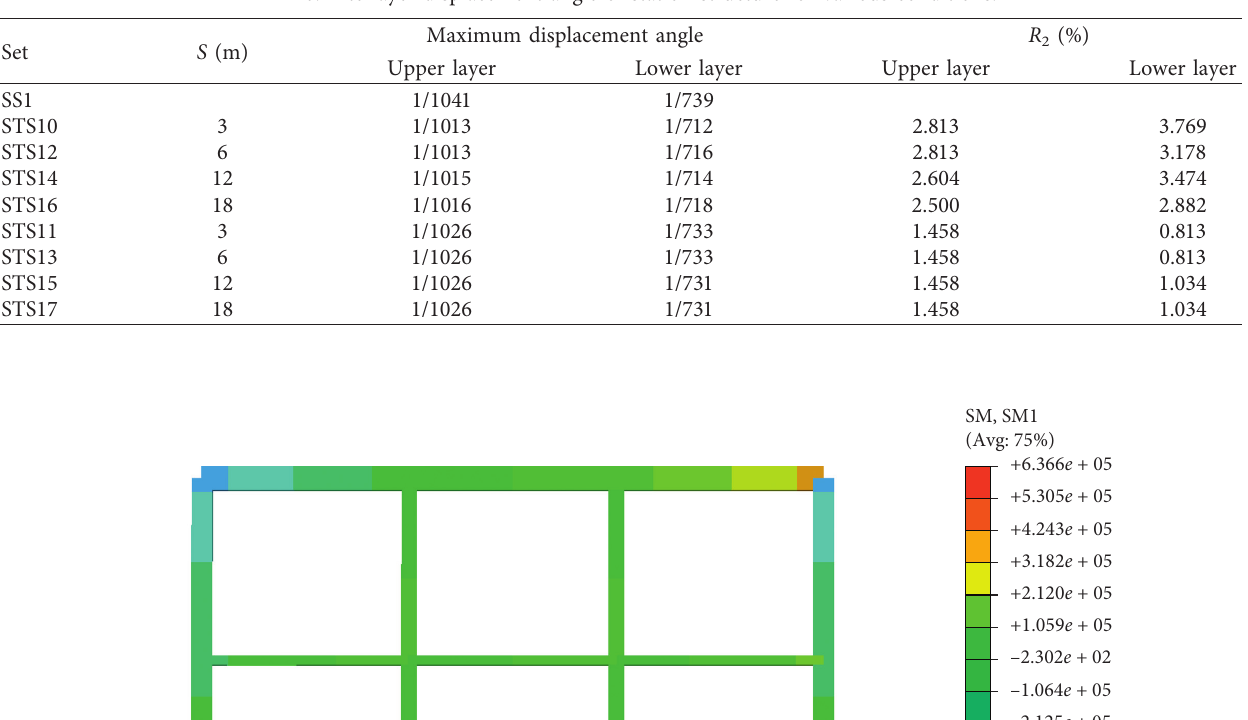
Figure 13: Interlayer displacement angle of the station structure. Table 6: Interlayer displacement angle of station structure for various conditions.